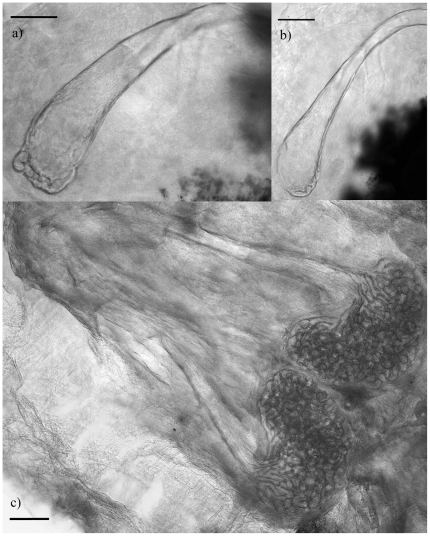
Copulatory spicules of Raillietiella frenatus and Raillietiella orientalis.(a) Copulatory spicule of male Raillietiella frenatus from Rhinella marina. Photograph is compiled from three focus-stacked images of the same field of view, scale bar is 0.05 mm. (b) Copulatory spicule of male R. frenatus from Hemidactylus frenatus. Photograph is compiled from two focus-stacked images of the same field of view, scale bar is 0.05 mm. (c) Paired copulatory spicules of male Raillietiella orientalis from R. marina. Note flared ornamented bases, scale bar is 0.1 mm.